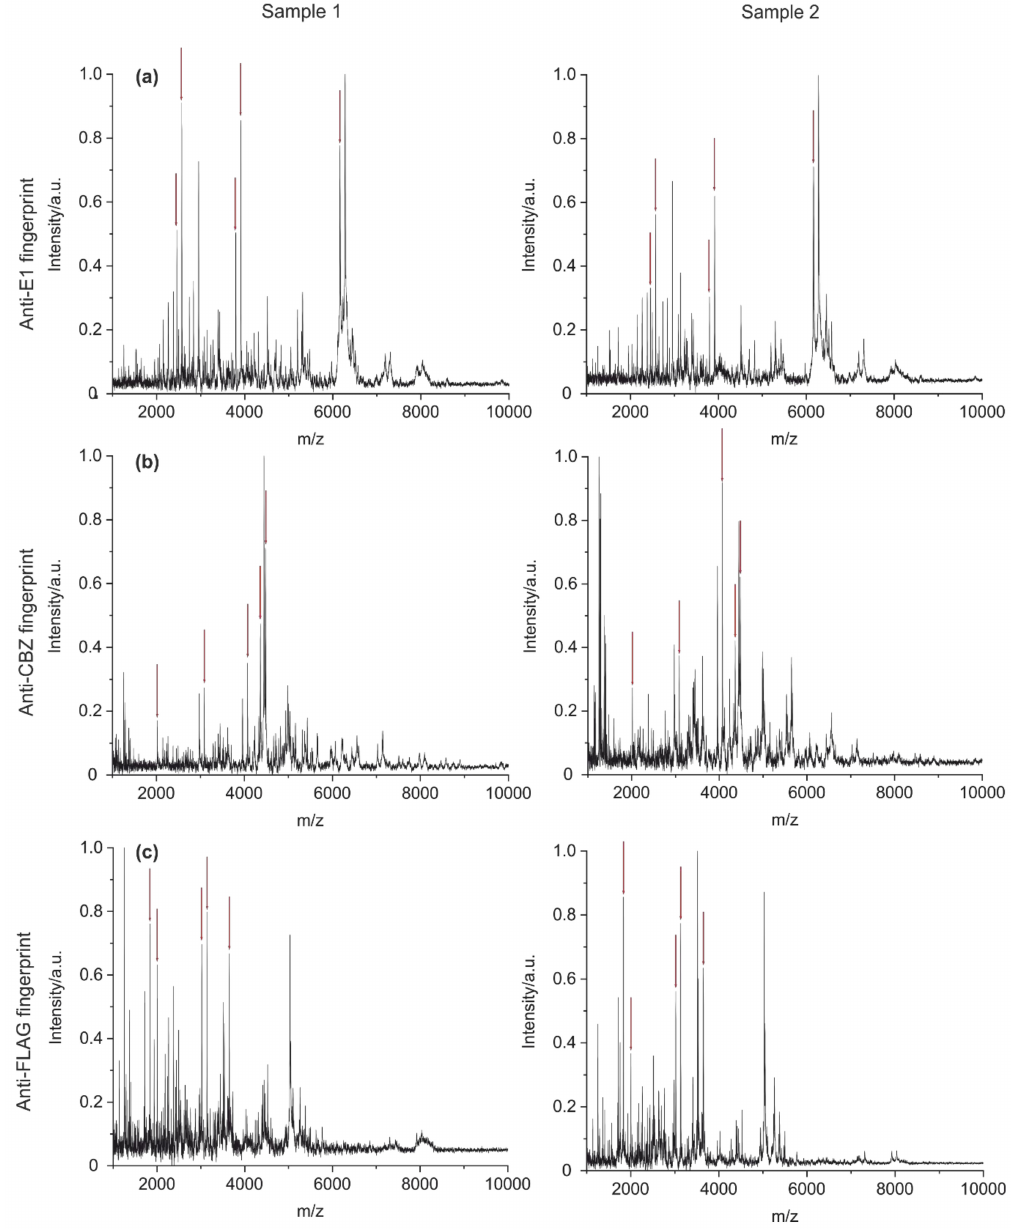
Figure 9. Comparison of fingerprints between three monoclonal antibodies E1 ( a ), CBZ ( b ), and FLAG M2 ( c ). Red arrows mark the five most intense signals from peptides that only occur in the fingerprint spectrum of the respective antibody. Multiple measurements from individual samples were taken. The unique peaks for each antibody were also found in the